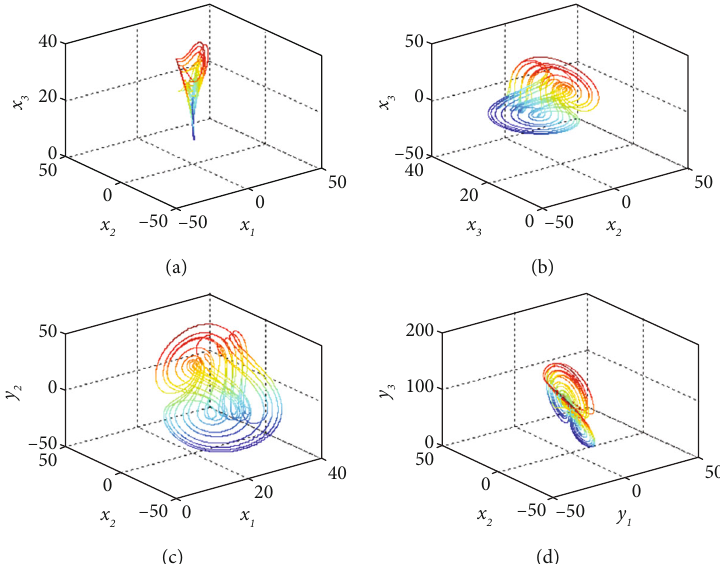
Figure 3: The chaotic trajectory of the unidirectionally coupled Chen system with the linear manifold y = Px + Q in 3D phase space: (a)